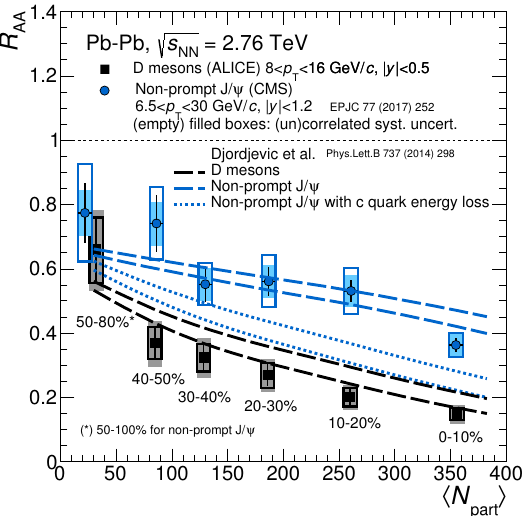
Figure 2 . Comparison of the R AA measurements with the calculations by Djordjevic et al. [4] including radiative and collisional energy loss. Lines of the same style enclose a band representing the theoretical uncertainty. For non-prompt J/ mesons in 6 : 5 < p T < 30 GeV =c [2] the model